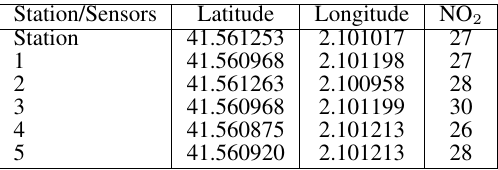
Table 2. Comparison between C-AQM provided data and reference station (day 10/05/2020).